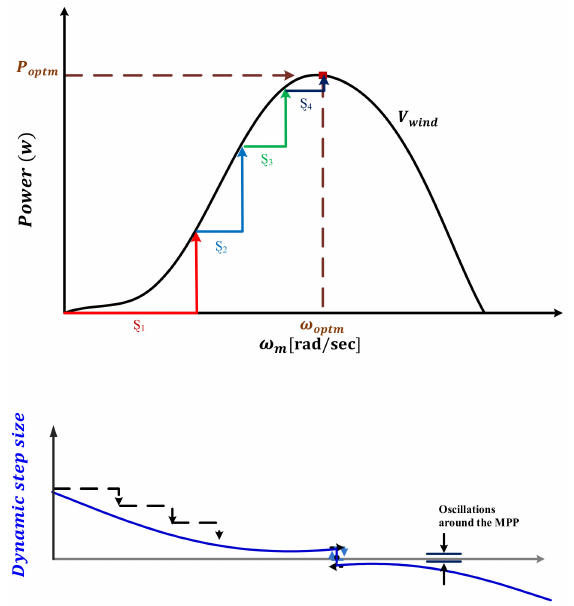
Figure 7. Proposed AD-HCS technique operation [62].